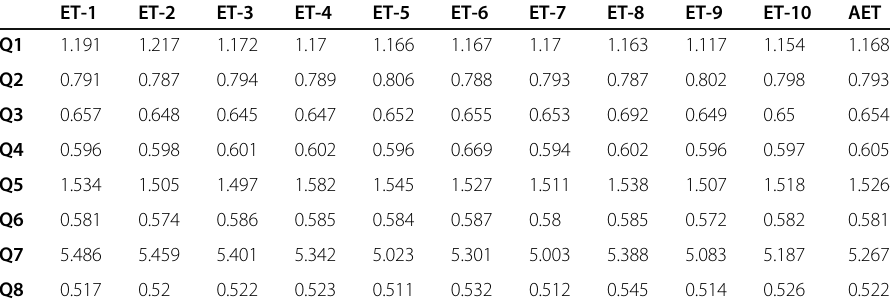
Table 7 Query execution time for Amazon EC2 with Washington State data in